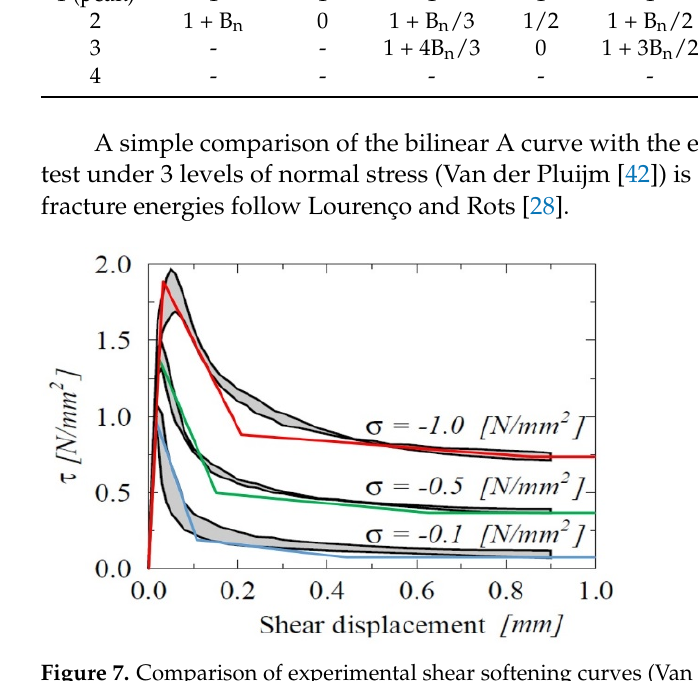
Figure 7. Comparison of experimental shear softening curves (Van der Pluijm [42]) with the approximation by a bilinear model.